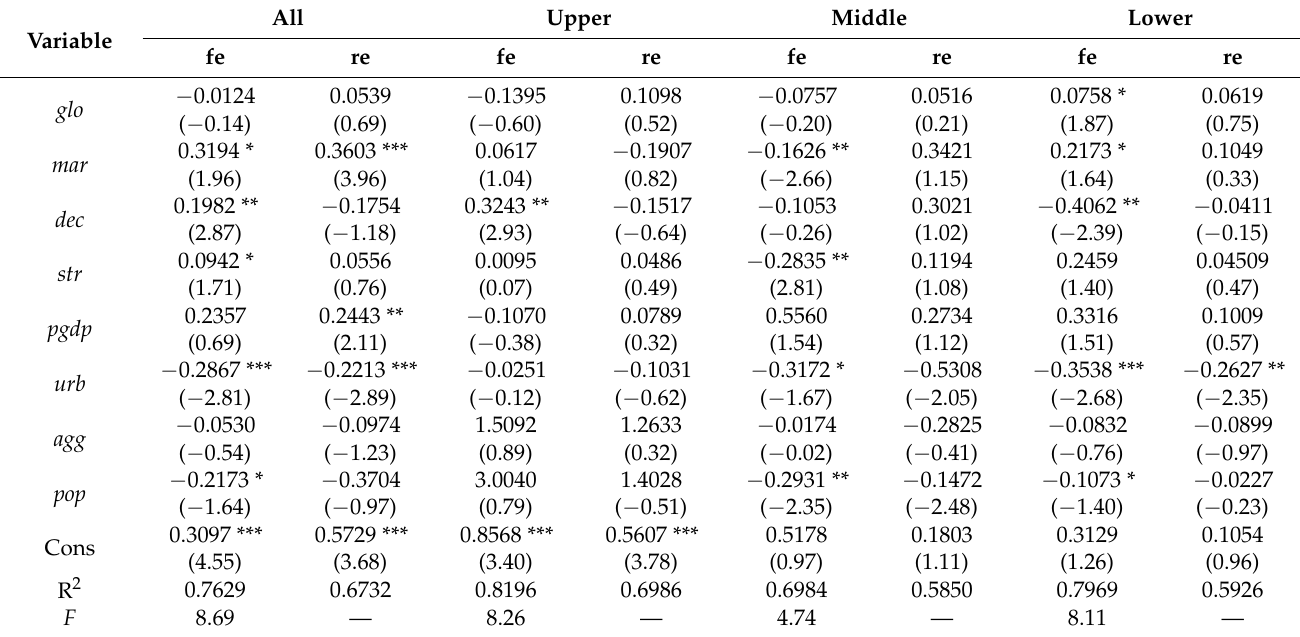
Table 5. Regression results of the influence factors of the LUE in the Yellow River